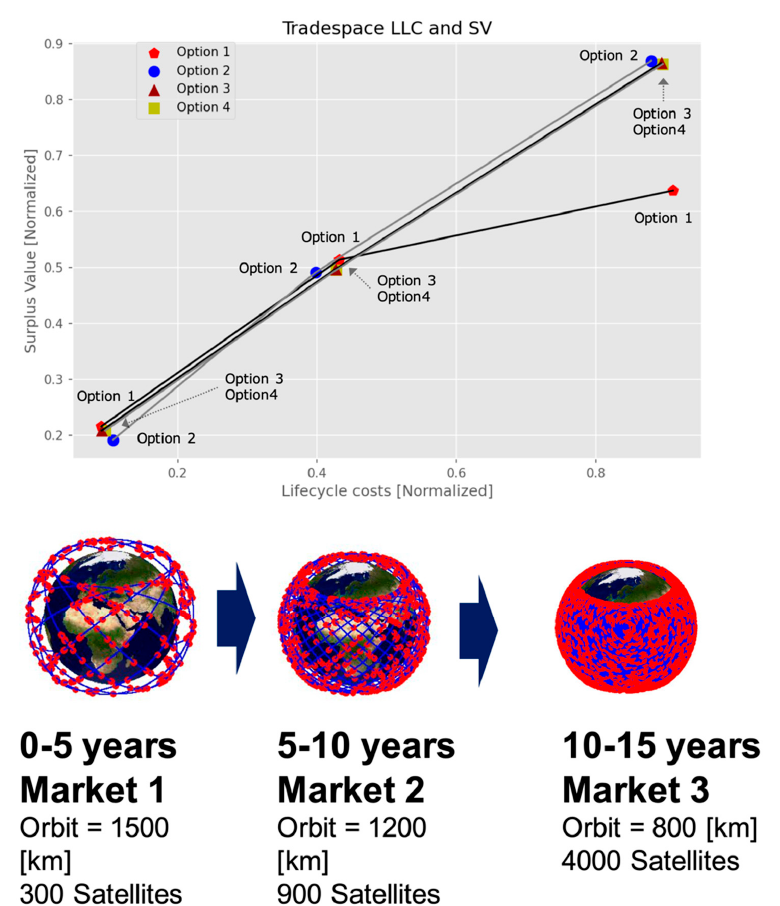
Figure 9. Average surplus value for the different options, considering the transitions between the different markets. The positions of the satellites in the lower part of the figure are taken randomly.